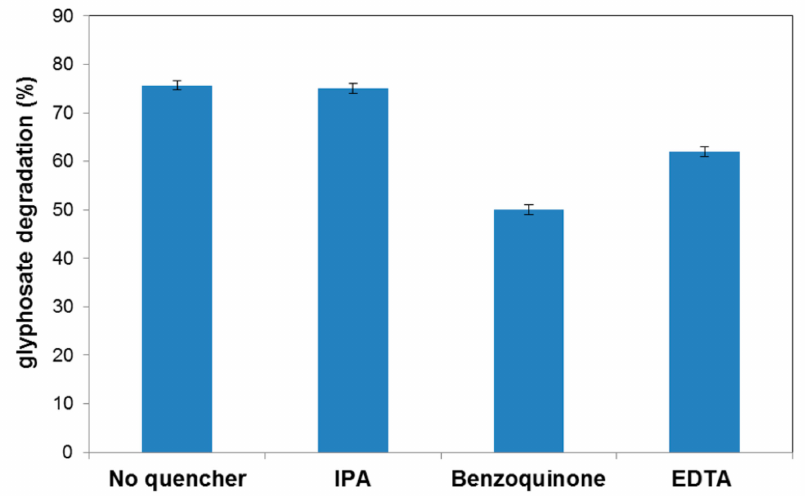
Figure 10. Trapping experiment of active species during the photocatalytic degradation of glyphosate under solar irradiation; initial glyphosate concentration: 10 mg/L; pH = 7; catalyst dosage = 1.5